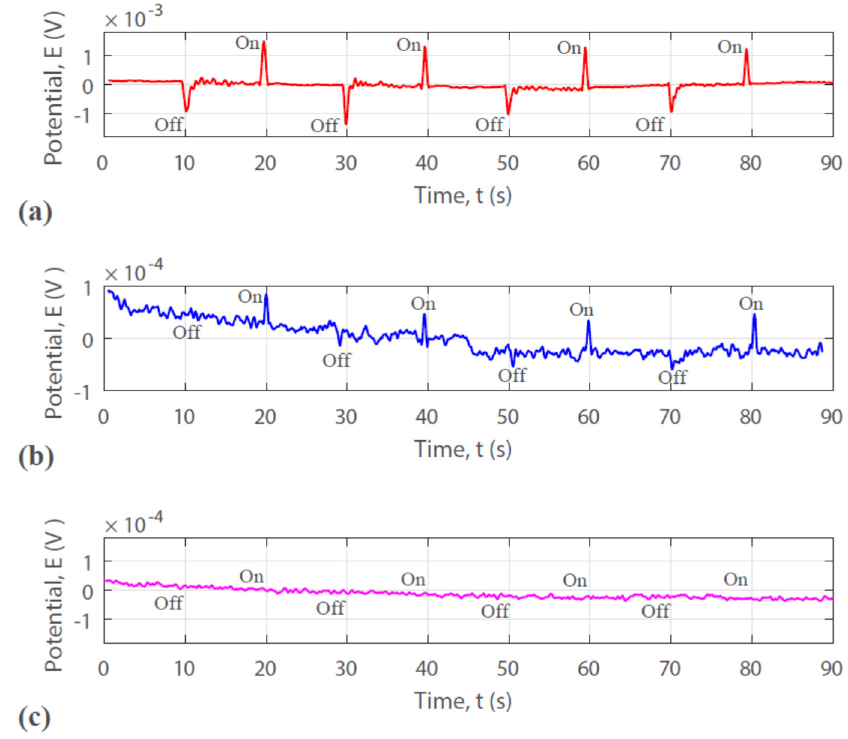
Figure 8. Open circuit potential vs. time showing the photosensitivity of the carbon fiber being treated at ( a ) 600 °C, ( b ) 650 °C, and ( c ) 800 °C.